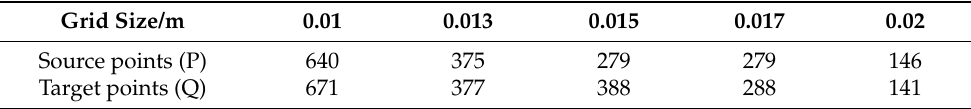
Table 2. Number of key points under different voxel sizes.